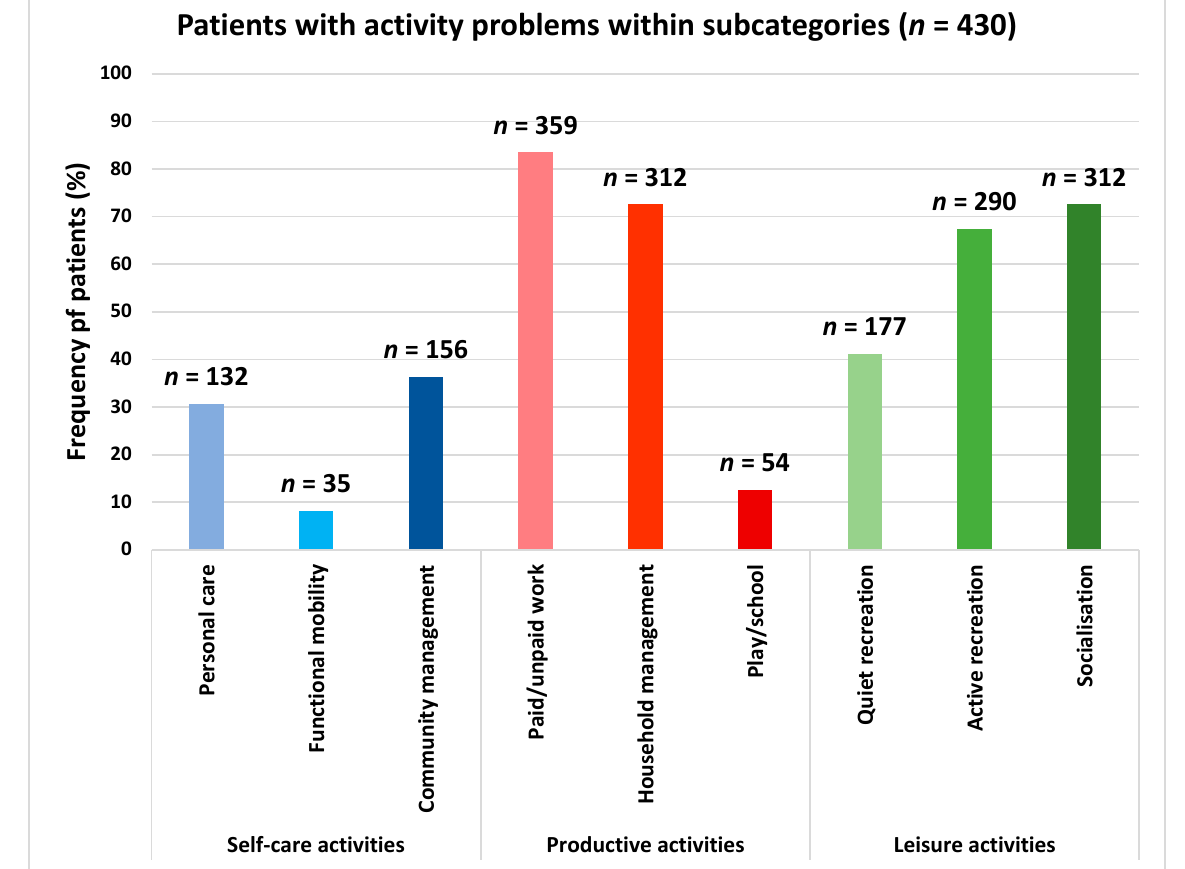
Figure 2. Patients with activity problems within the overall COPM categories: self-care activities (blue), productive activities (red) and leisure activities (green). Frequency ( n ) and relative frequency (%) of patients reported. COPM data is based on 430 patients.